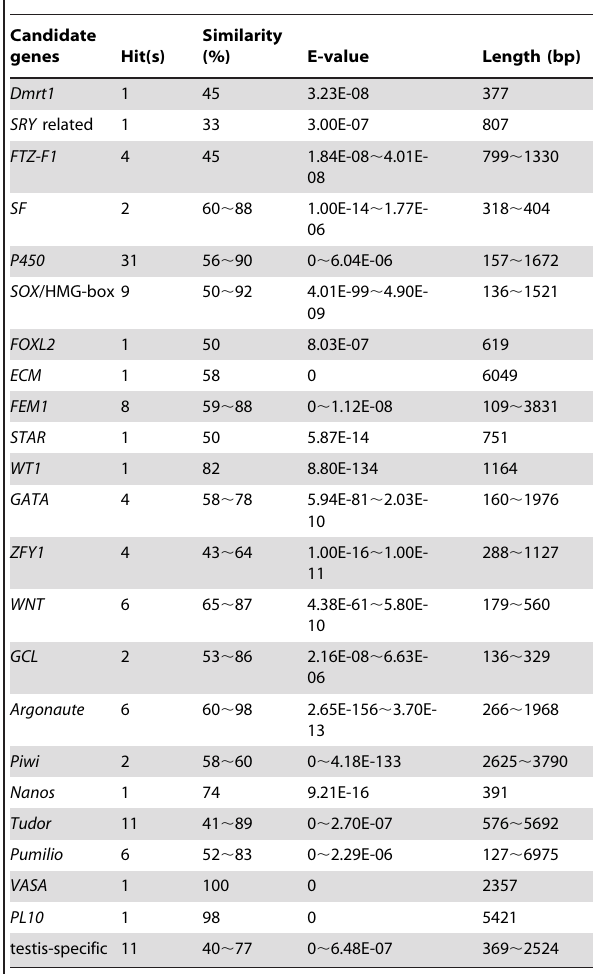
Table 2. Selected genes of interest for sex determination/ differentiation in the M. nipponense transcriptome, including the contigs and